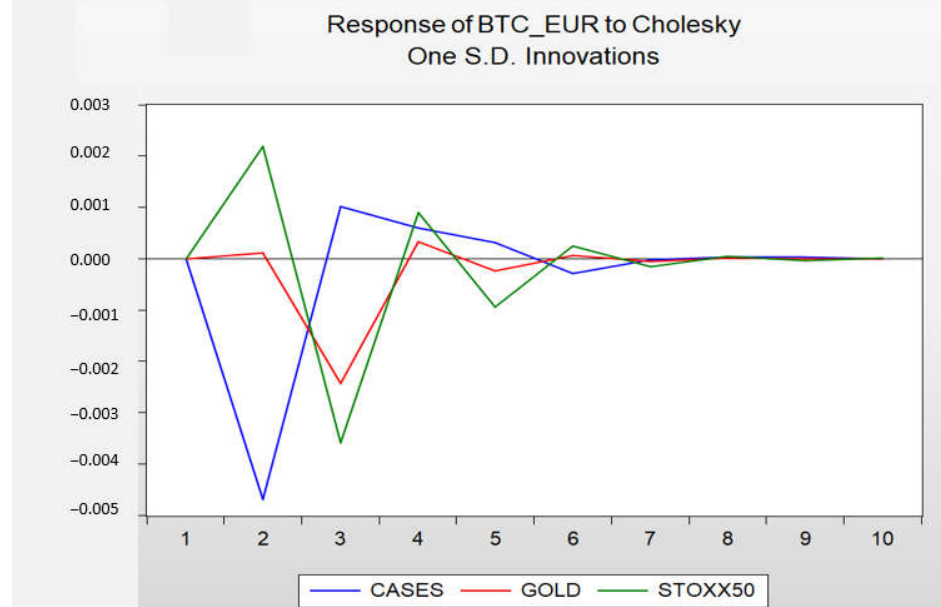
Figure 6. Impulse response of BTC/EUR to all. Int. J. Financial Stud. 2023 , 11 , x FOR PEER REVIEW